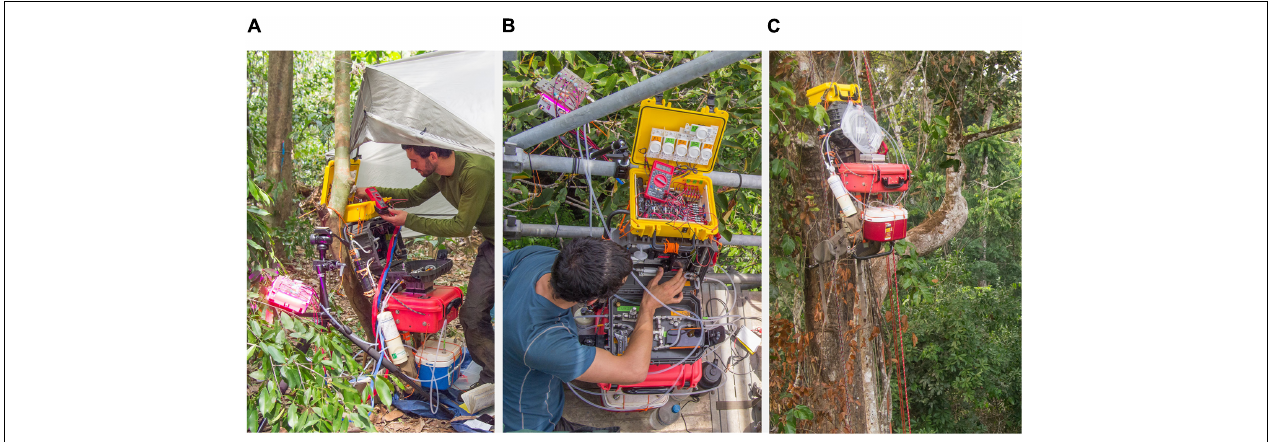
FIGURE 12 | Field measurements with PORCO in a tropical forest: (A) on the ground with cut branches; (B) on a canopy walk-up tower for in situ measurements on intact branches; (C) hauled into the canopy for in situ measurements from a suspended walkway. Subject in images is the lead author of the present